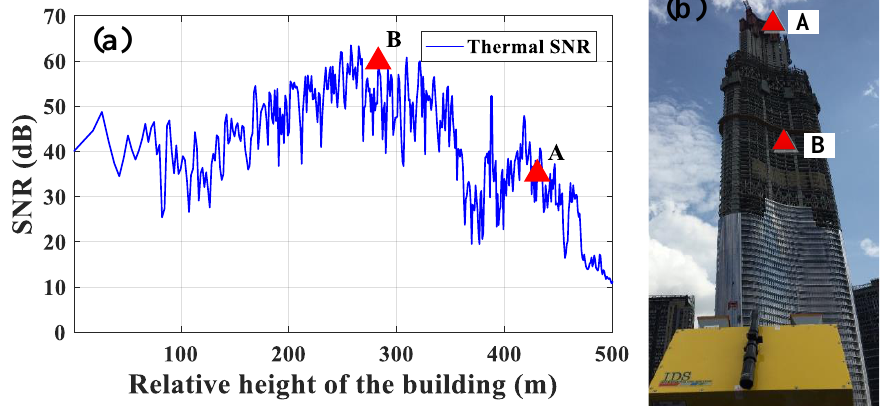
Figure 6. (a) Power profile of the WGC obtained from working base point S1 and selection of monitoring points. The red triangle denotes the monitoring point. The relative height of the building in the left figure is relative to working base point S1. Point A in the right figure is at the top of the building, with a height of 447 m relative to working base point S2. Point B is 300 m high relative to working base point S2. (b) Ground view of the WGC from the location of the IBIS-S-1 system.